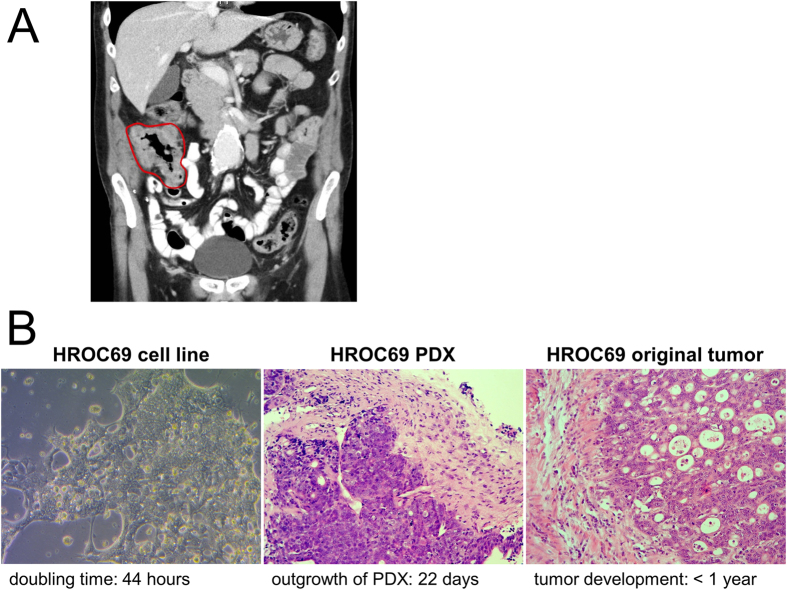
Patient tumour and model imaging.(A) CT-scan showing the large tumour affecting cecum and ascending colon (red surrounding)–without proof of distant metastases. (B) micro-photographs (20×) of the patient-derived cell line HROC69, an H&E stain of HROC69 PDX and an H&E stain of patient HROC69 tumour. The time for tumour (model) growth is indicated below each image.